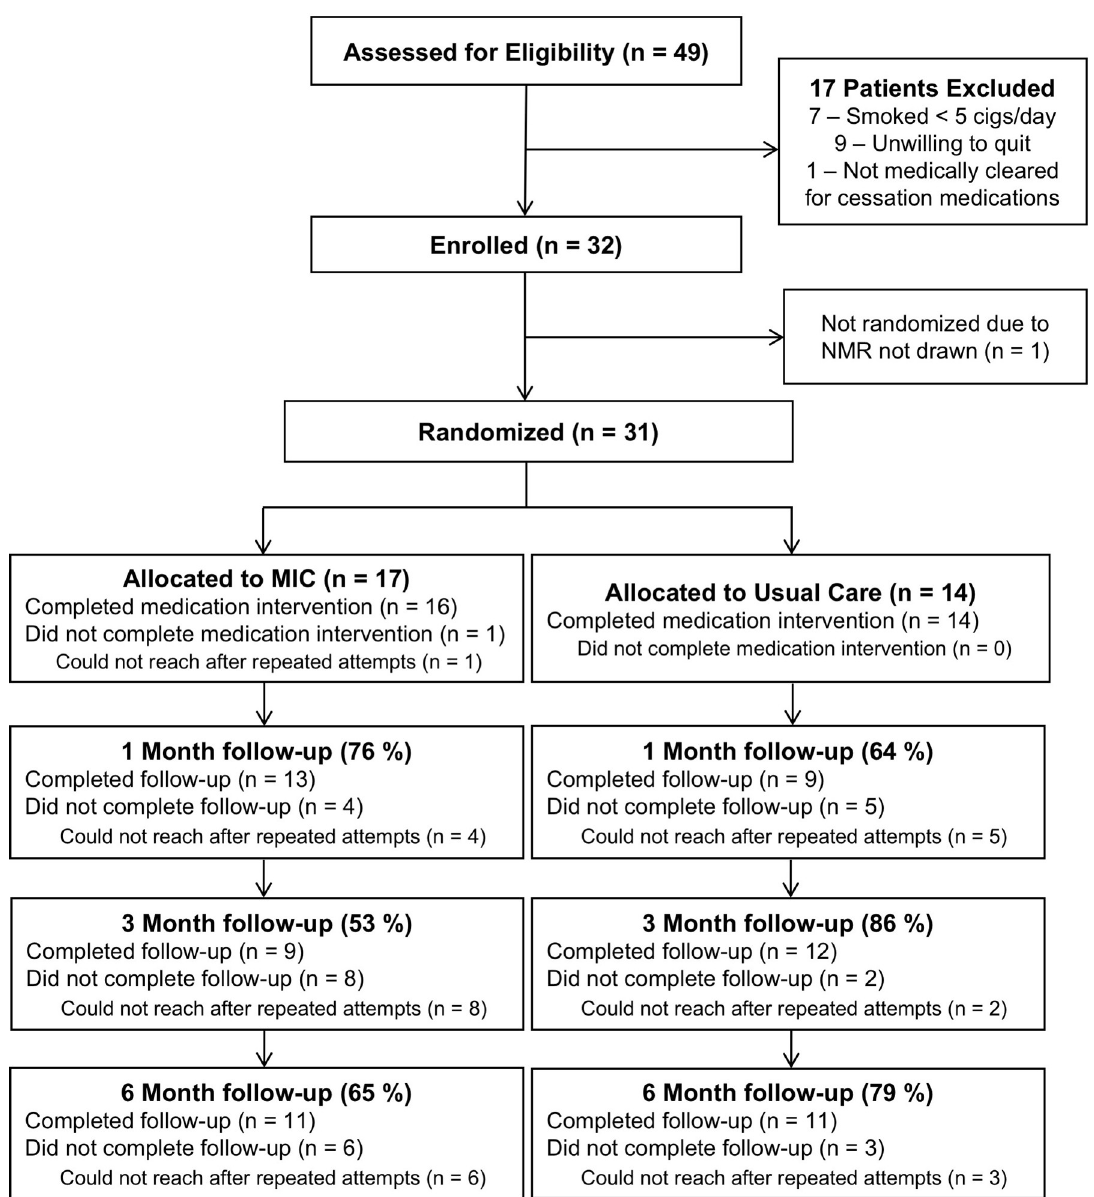
Fig 2. Flow of participants in the nicotine metabolite ratio intervention. Thirty-two subjects participated in this randomized pilot intervention using nicotine metabolite ratio (NMR) to guide smoking cessation. illness than other smokers. The distribution was similar between treatment groups (2 MIC, 2 usual care, and 1 not randomized). Medication was accepted by 30 (93.7%) and Quitline refer- ral by 28 (87.5%) patients. Of the two patients who did not accept medication one could not be randomized due to lab error and the other in the MIC group could not be reached by tele- phone. Three patients who did not accept Quitline services were all in the MIC group and 1 was not randomized. Five patients (4 usual care, 1 MIC) reported that their medication choice (all avoided varenicline) was based on a concern for potential side effects. Detailed survey information based on randomization groups is available in ( S2 Table ).